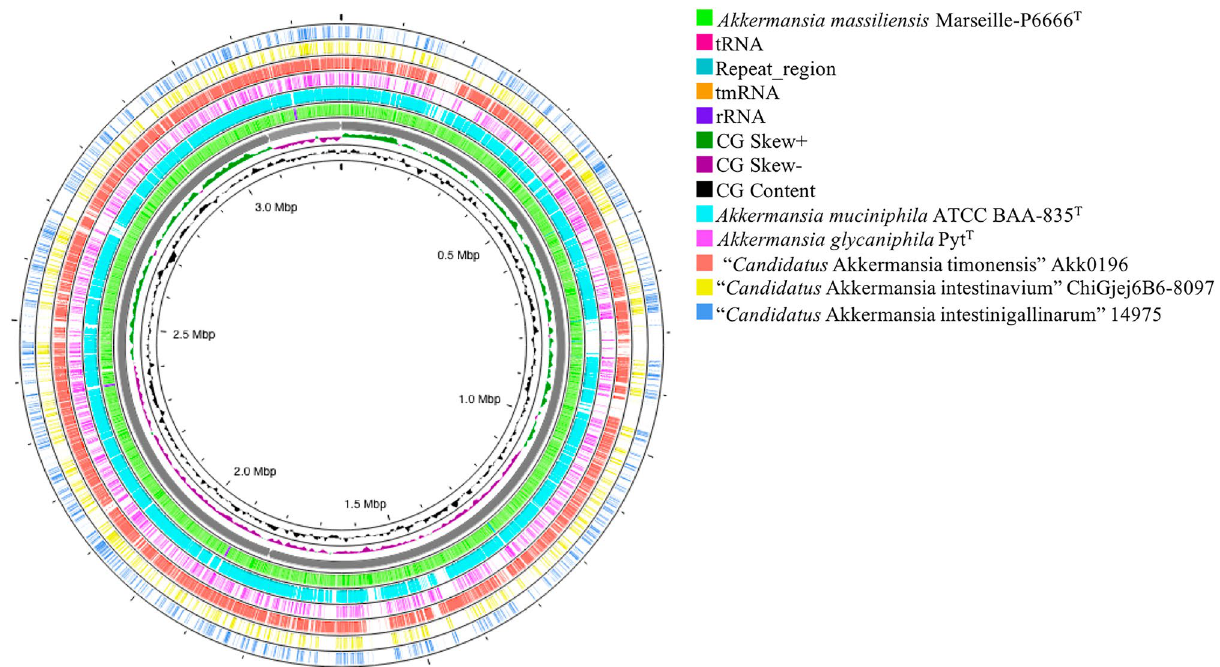
Figure 2. Graphical circular map of A. massiliensis Marseille-P6666 uses as reference genome to compare the genomic organization of the closest species of published Akkermansia such as Akkermansia muciniphila strain ATCC BAA-835 T , Akkermansia glycaniphila strain Pyt T , Candidatus Akkermansia intestinavium” strain ChiGjej6B6-8097 T and Candidatus Akkermansia intestinigallinarum” strain 14975 T , and the new species candidate “ Candidatus Akkermansia timonensis” strain Akk0196. The different colors used in the circular map are indicated in the legend on the right part of the figure.